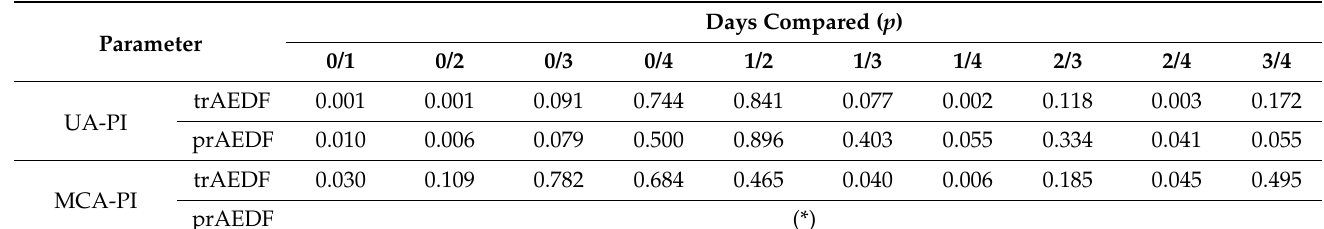
Table 2. Post-hoc analysis for comparing the pulsatility indexes (PIs) registered on different days, between day 0 (prior) and the first 4 days after maternal dexamethasone administration, in the case of a significant ( p < 0.05) Kruskal-Wallis test. The test was significant for UA-PI in both groups and for MCA-PI in the trAEDF group. (*) For MCA-PI in the prAEDF group, the Kruskal-Wallis test was nonsignificant ( p > 0.227).